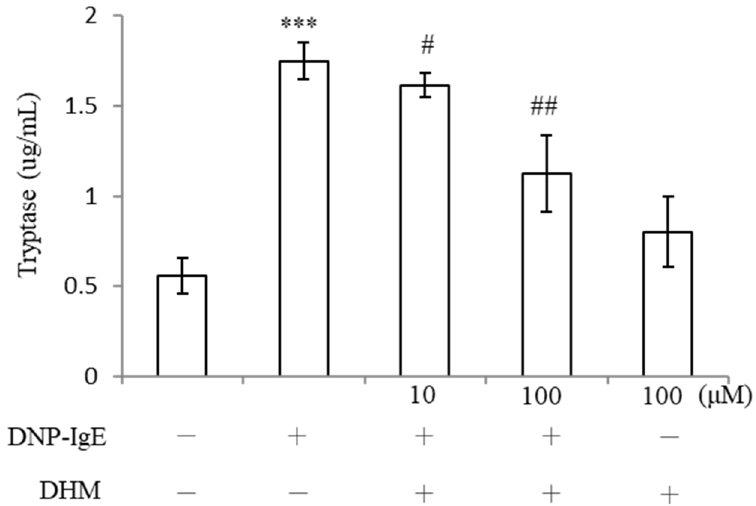
Figure 4. DHM reduced degranulation from KU812 cells after IgE-DNP-induced activation. KU812 cells were either sensitized with DNP-IgE or treated with DHM. The amount of tryptase from a million cells released into the supernatants was quantified using a degranulation kit after 24 h of incubation. Data represent the mean ± SD of three independent experiments. *** p < 0.001 as compared with untreated control and # p < 0.05, ## p < 0.01 as compared with